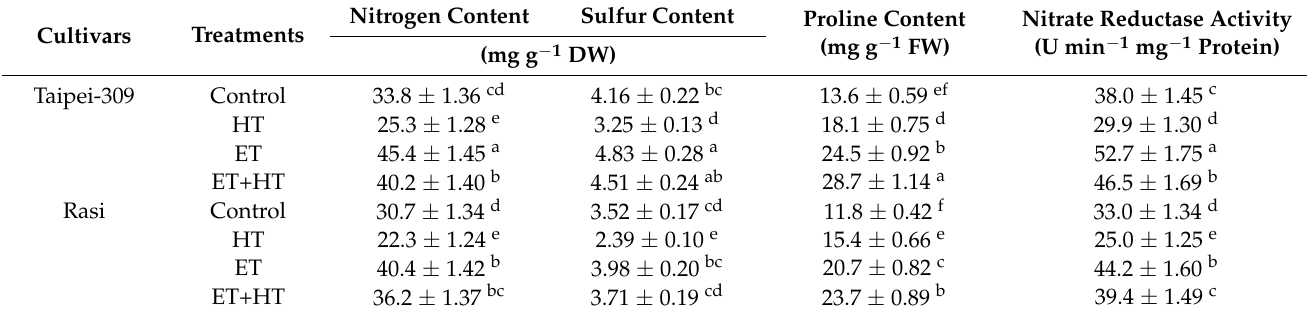
Table 4. Content of leaf nitrogen, sulfur, and proline, as well as nitrate reductase activity, in Taipei- 309 and Rasi cultivars of rice ( Oryza sativa L.) at 30 DAS. Plants were grown with/without high- temperature (HT) stress and treated with a foliar spray of 1.6 mM ethephon (ET) at 15 DAS. Data are presented as treatment means ± SE ( n = 4). The values followed by the same letters did not differ significantly by the LSD test at p < 0.05. FW, fresh weight; DW, dry weight; DAS, days after sowing.